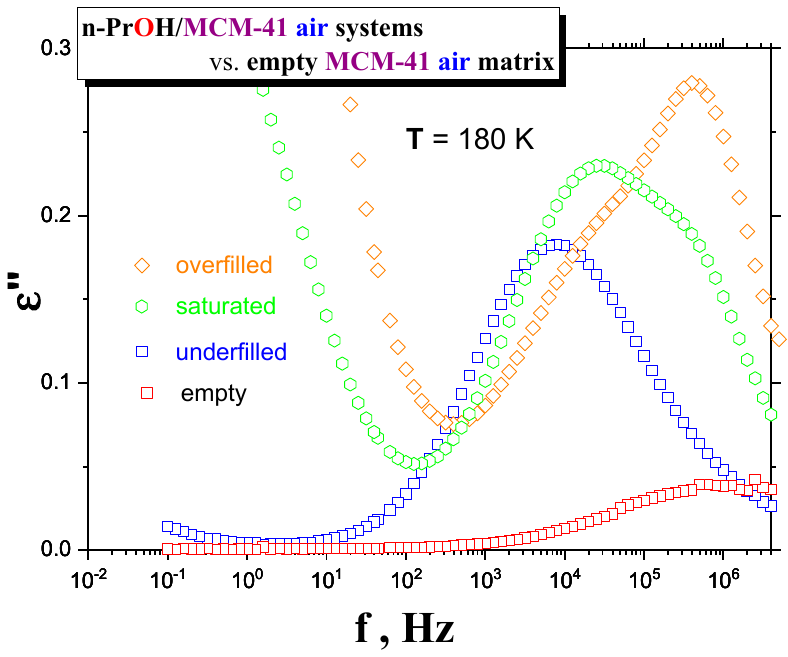
Figure 4. Comparison of the BDS spectra at 180 K of empty MCM-41 matrix vs. underfilled, saturated and overfilled n-PrOH/MCM-41 , air systems after cooling with − 2 K/min from RT down to 100 K and subsequently isothermal measured with Δ T = 5 K step up to 300 K.